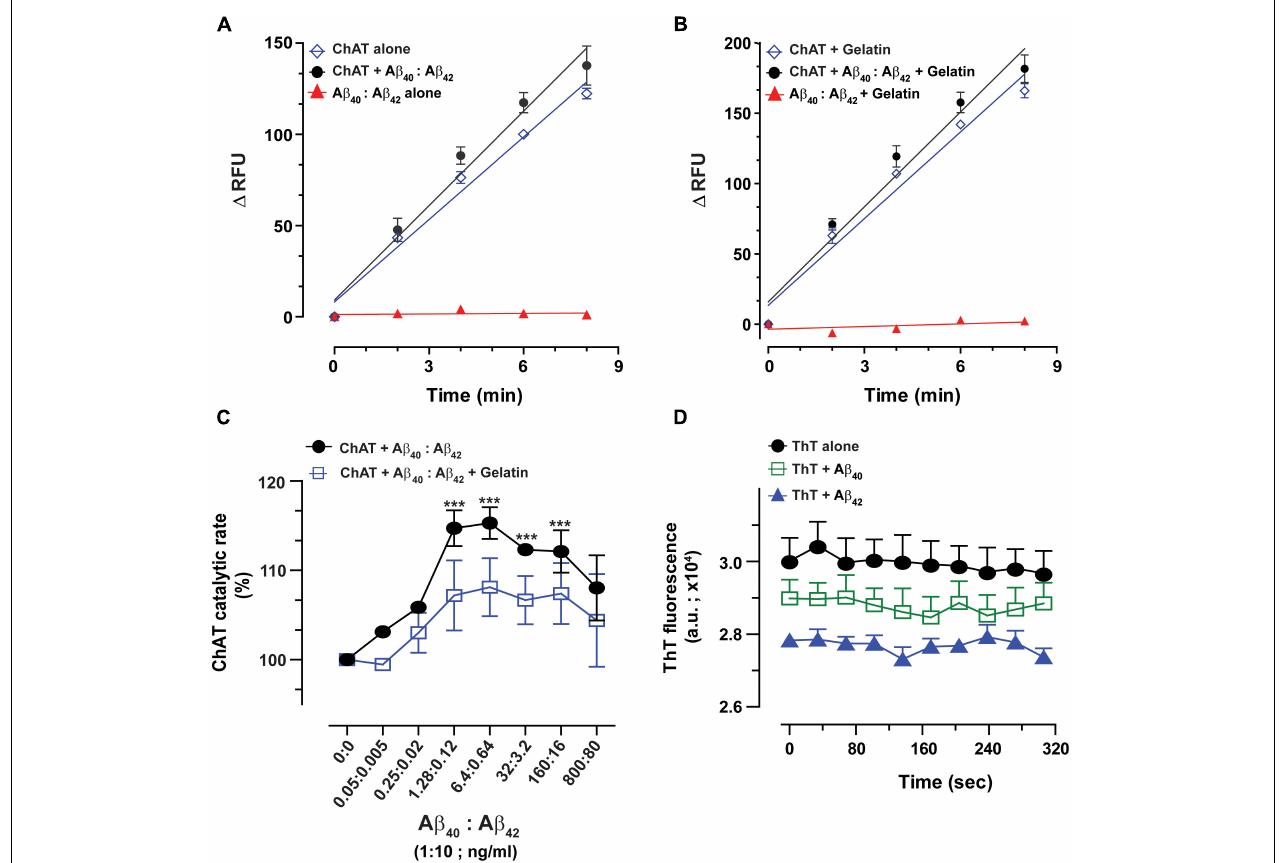
FIGURE 5 | The enhanced catalytic efficiency of ChAT is persistent at a physiological ratio of A β 40:A β 42 mixture. Both A β 40 and A β 42 are present simultaneously in biological fluids at a 10:1 ratio. Therefore, we measured the ChAT activity in the presence of various concentrations of mixtures of A β peptides to somewhat mimic the in vivo conditions. The graphs (A,B) illustrate the kinetic rate of ChAT activity ( (cid:49) RFU/min) alone or in the presence of a mixture of A β 40/42 (6.4/0.64 ng/mL) with and without 1 mg/mL gelatin, respectively. The data is fitted using linear regression function of the GraphPad Prism 7. The values are shown as mean ± SD of ≥ 2 readings. Graph (C) shows the percent changes in ChAT activity at the specified A β mixture concentrations with or without gelatin. The activity of control sample (ChAT with no A β ) was considered as 100%. The values are shown as mean ± SEM of ≥ 2 independent experiments. ∗∗∗ p < 0.0001, relative to the control (no A β ), based on one-way ANOVA analysis and Fisher’s LSD post hoc test. (D) To ensure that the soluble A β peptides were responsible for ChAT activation, we monitored the degree of A β fibrillization at highest experimental concentrations (800 ng/mL A β 40 and 100 ng/mL A β 42) using Thioflavin-T (ThT) assay. No significant difference in the ThT fluorescence intensity was observed between A β containing wells and control wells (no A β ). The values are shown as mean ± SEM of three